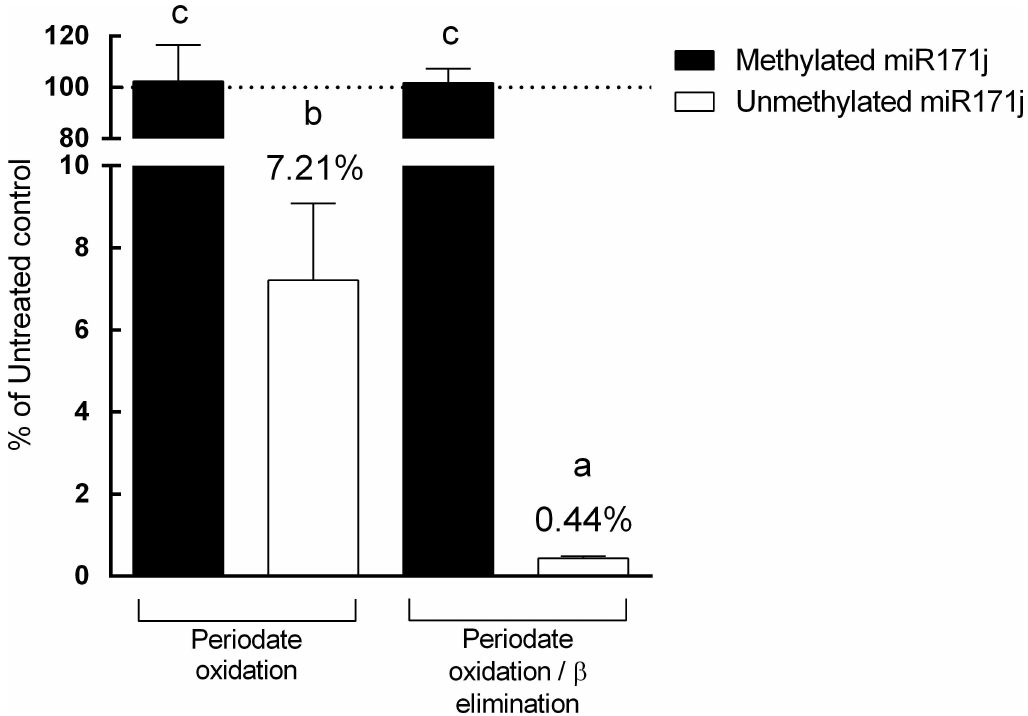
Fig 3. Comparisonof periodate oxidation and β elimination methods. 20 ng of methylated miR171jor unmethylated miR171jweretreatedwith 1) periodateoxidation,or 2) periodateoxidationfollowedby β elimination,andanalyzedby qRT-PCRas describedin Materials andMethods. Datais presented as a percentageof miR171jdetectedin the treatmentgroupto that of the controlgroup.Columnsmarked withdifferentlettersare significantly differentfrom each other ( p (cid:20) 0.05, data presentedas Mean ±